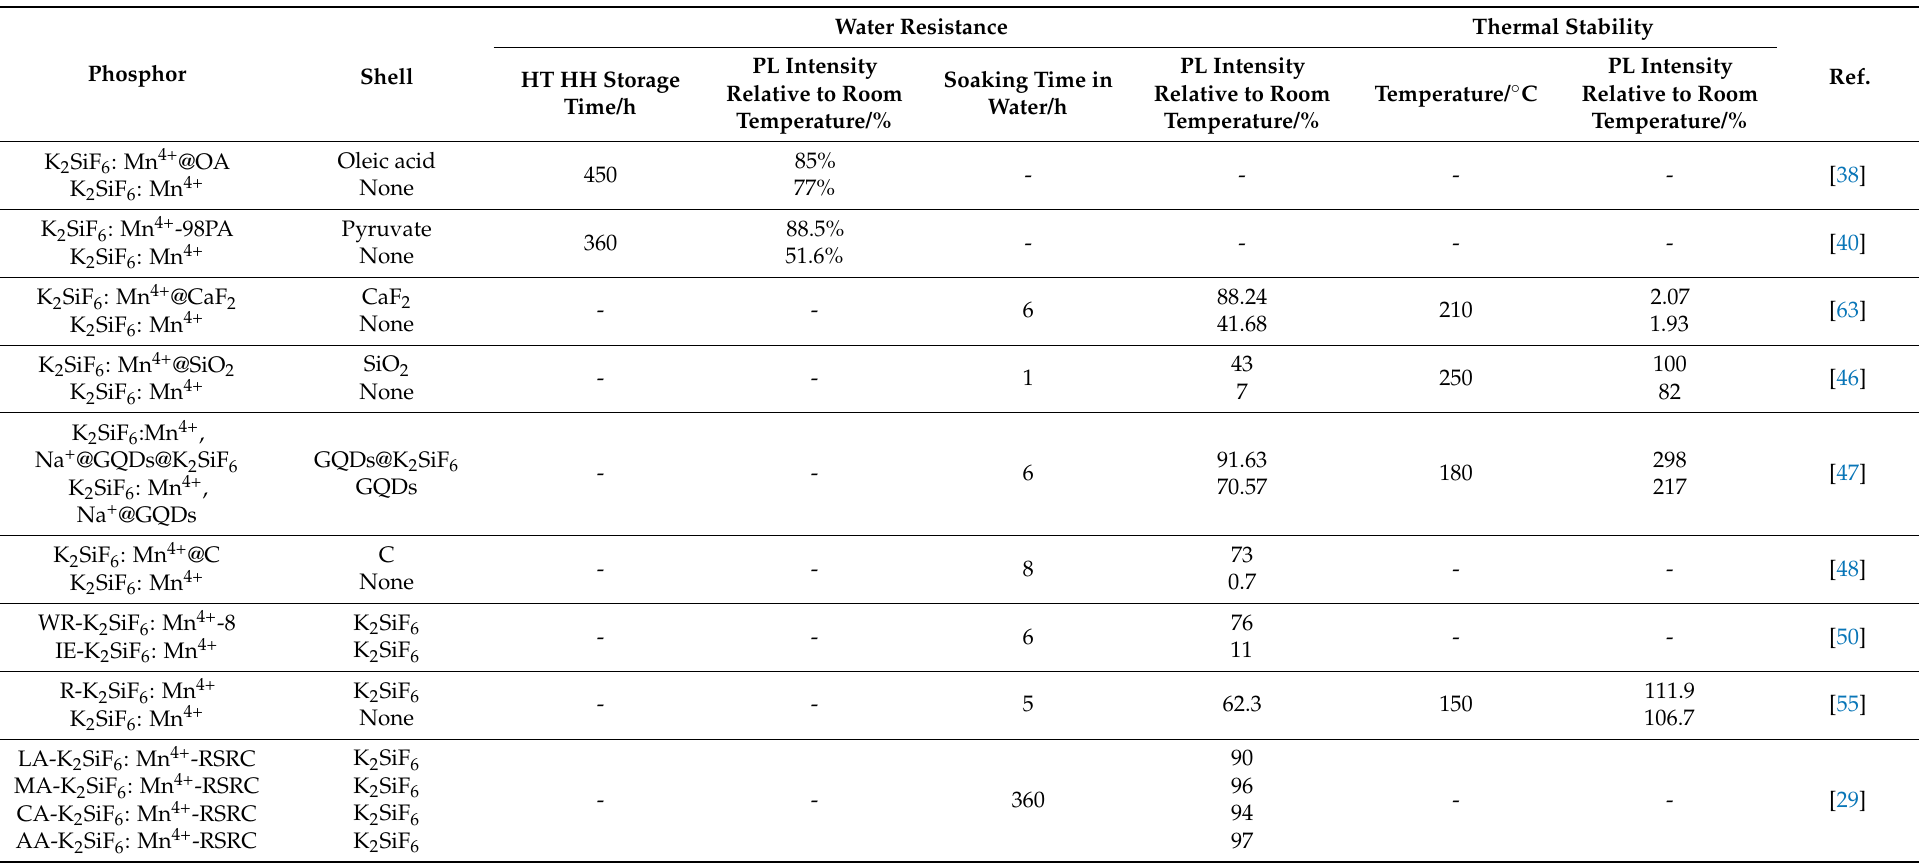
Table 1. Comparison of water resistance and thermal stability of A 2 MF 6 : Mn 4+ red phosphor with and without core–shell structures.